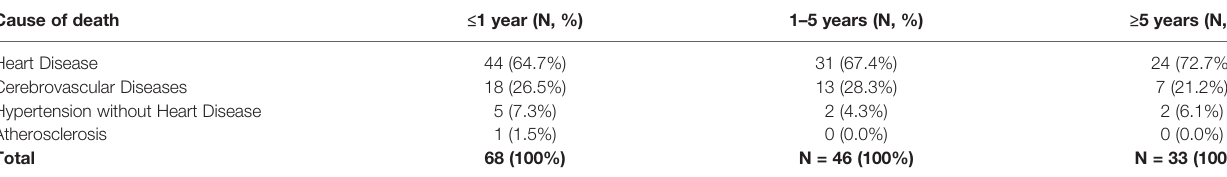
Bold values mean statistical signi fi cance (P <